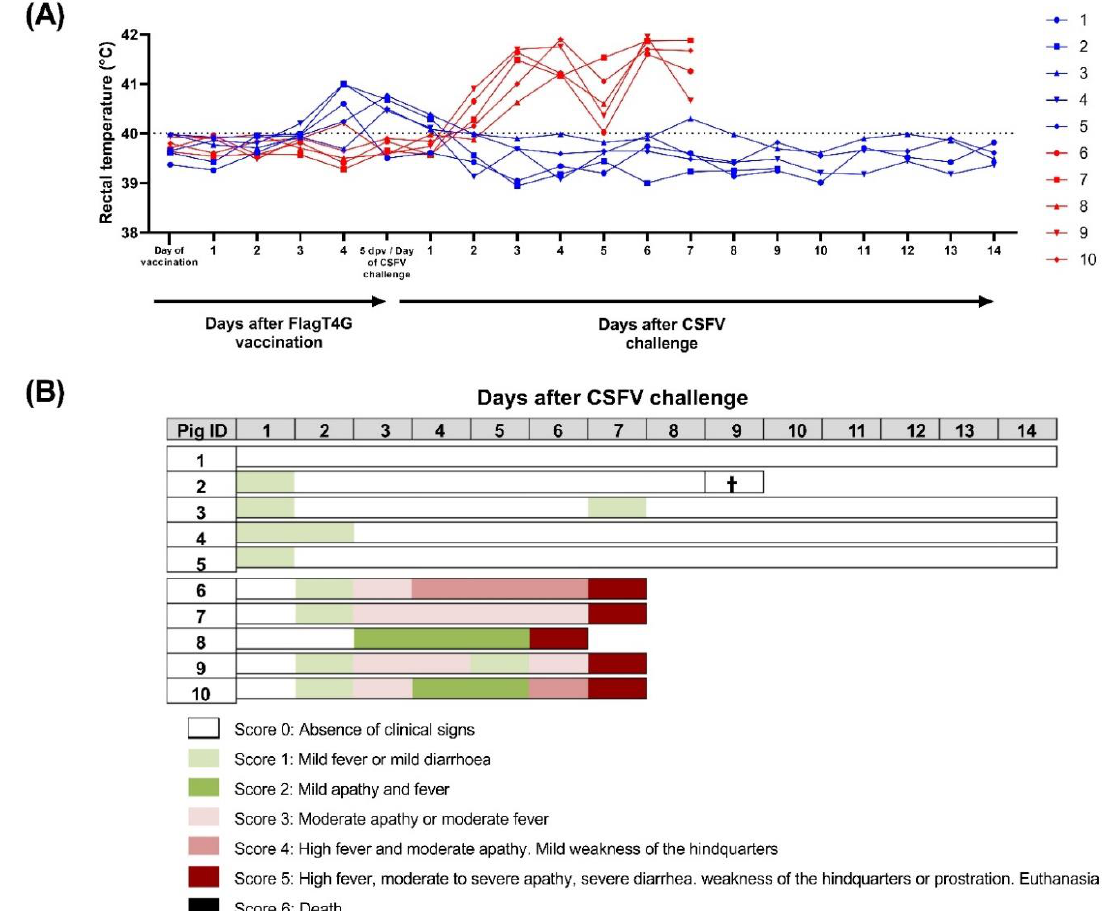
Figure 1. Clinical signs and rectal temperature in pigs during the trial. Individual rectal temperature ( A ) was recorded in FlagT4G-vaccinated (blue lines and symbols) and unvaccinated (red lines and symbols) pigs throughout the trial. Values above 40 ◦ C (dotted line) were considered as fever. ( B ) A numeric clinical score value (represented in colorimetric scale) was assigned for each animal after CSFV challenge. Cross symbol indicates an animal that died during monitoring, despite not showing clinical